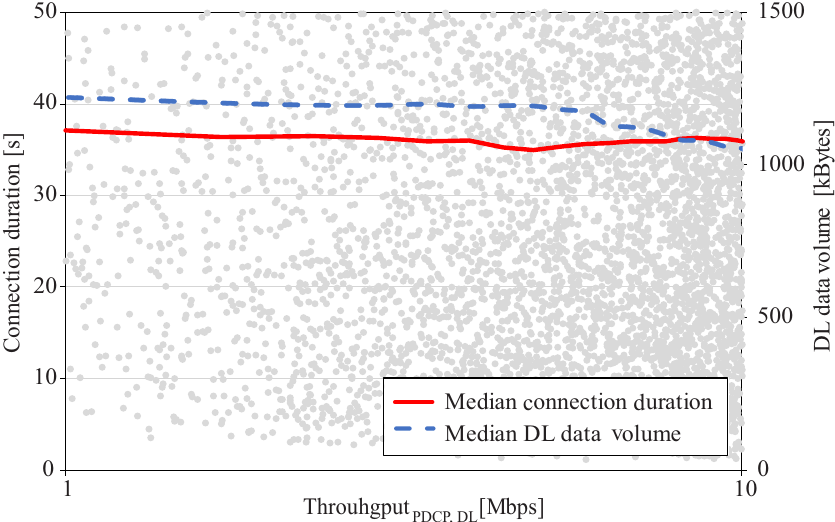
Figure 6. QoS and traffic indicators for social networks and web browsing services (small